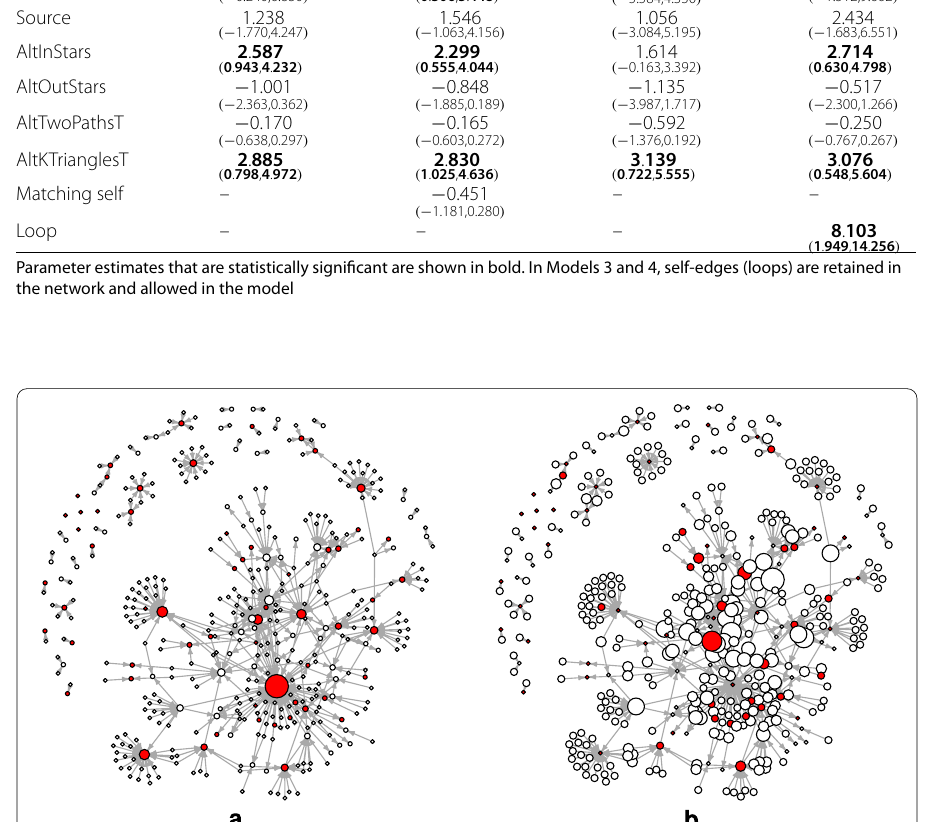
Fig. 5 Alon E. coli regulatory network. ( a ) Node size is proportional to in-degree. ( b ) Node size is proportional to out-degree. Self-regulating operons are depicted as filled (red) circles. In ( a ) there appears to be a small set of high in-degree nodes and a much larger set of smaller in-degree nodes, while in ( b ) the out-degree